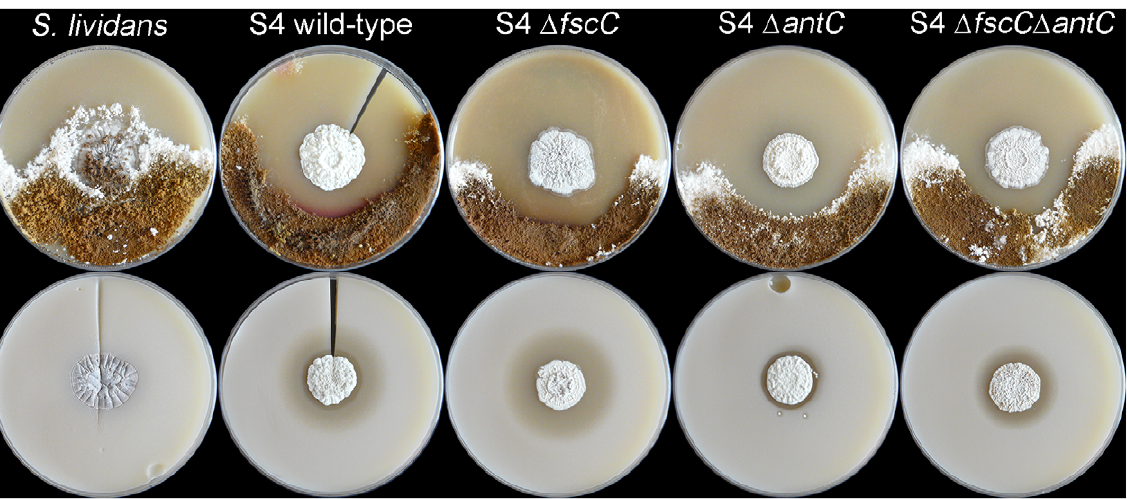
Figure 2. Antifungal bioactivity of the non-antifungal-producing strain Streptomyceslividans , Streptomyces S4 wild-type and mutant strains. Bioassays with Streptomyces lividans , S4 wild-type, S4 D fscC , S4 D antC and S4 D fscC D antC against Escovopsis weberi (top panel) and C. albicans (bottom panel) demonstrate that deletion of fscC does not abolish antifungal activity and that deletion of antC only reduces antifungal activity against C. albicans and not E. weberi . The S4 D fscC D antC double mutant does not display reduced antifungal activity against E. weberi suggesting the presence of an additional antifungal compound that is responsible for the phenotype observed during in vitro bioassays.